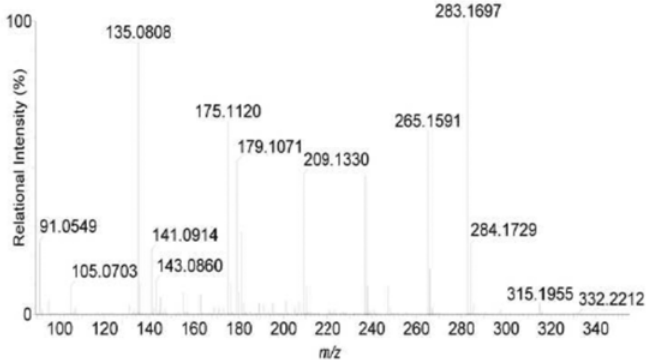
Fig 7. Liquid chromatogram-mass spectrum (LC-MS) profile of product C.